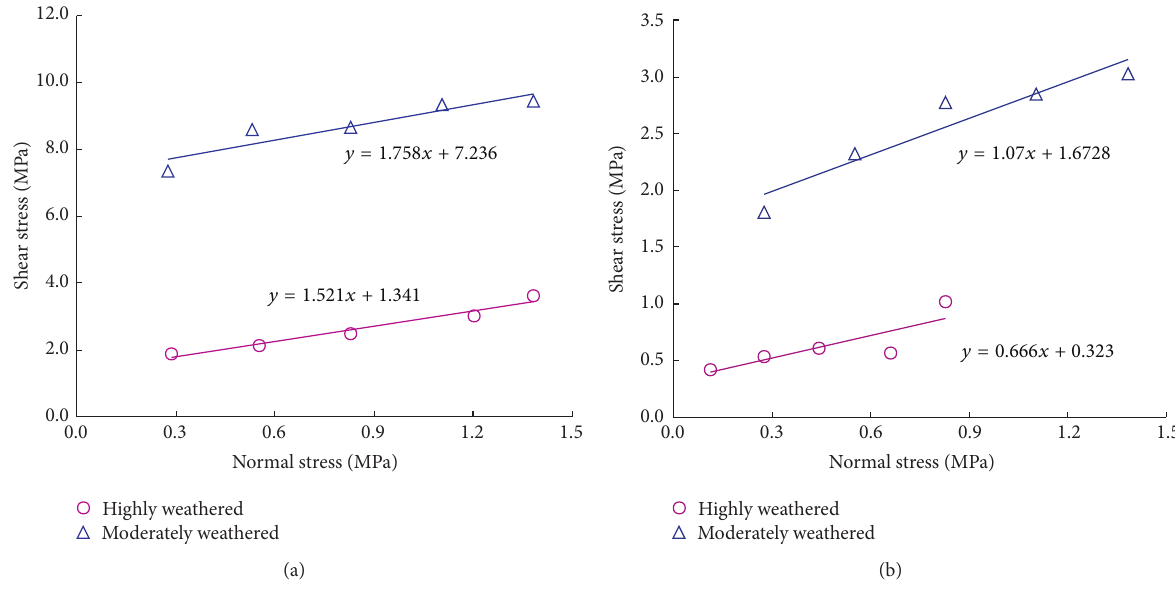
Figure 8: The results of the direct shear tests: (a) natural rock samples and (b) saturated rock